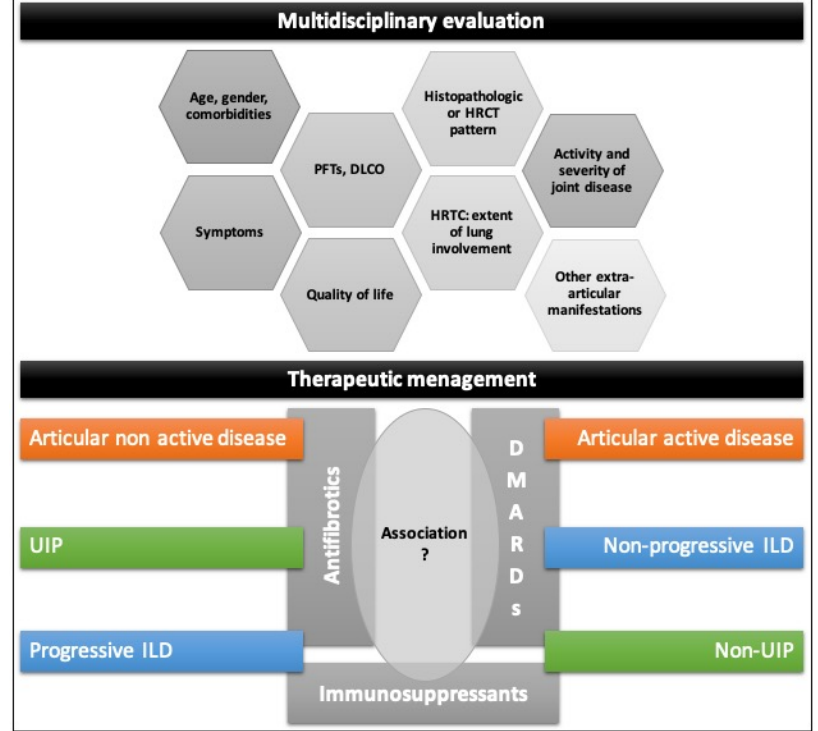
Figure 5. Proposed framework for the management and treatment of RA-ILD patients. Therapeutic choice in patients with RA-ILD should derive by a multidisciplinary approach including a rheumatologist, pulmonologist, and radiologist. Use of DMARDs (mainly ABA, JAK inhibitors, IL6 inhibitors or RTX) should be evaluated according to the joint disease activity, while the progression of lung involvement and, possibly ILD pattern, can influence the decision to use immunosuppressants or, in selected patients, an antifibrotic drug.